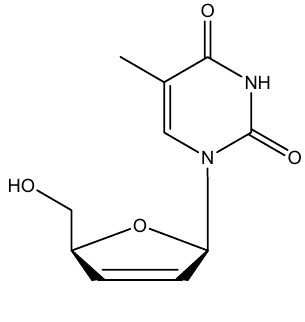
Fig. 1 – Structure of